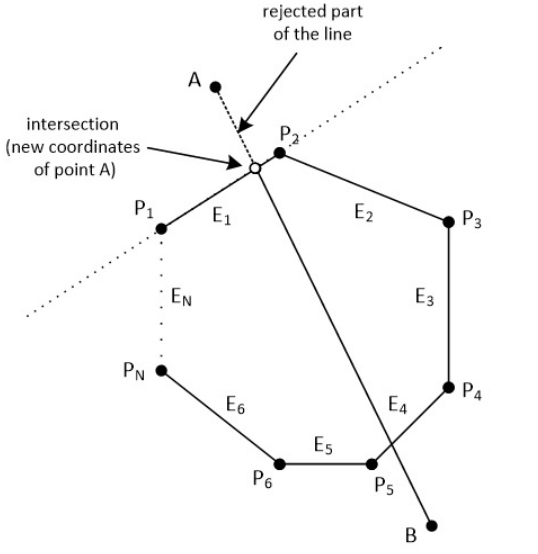
Figure 41. The intersection point replaces the point that it is outside the polygon.